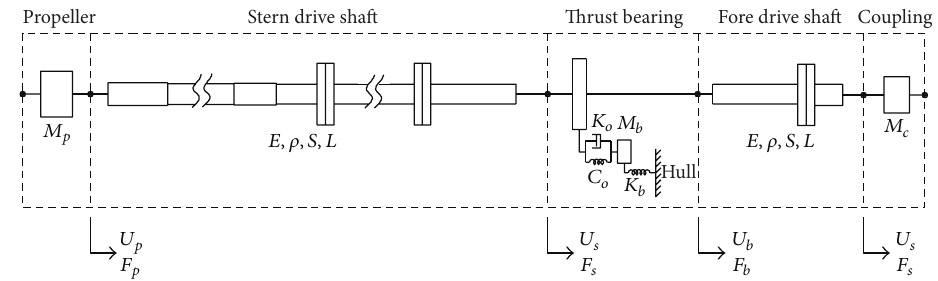
Figure 2: Modular representation of propulsion shafting system.